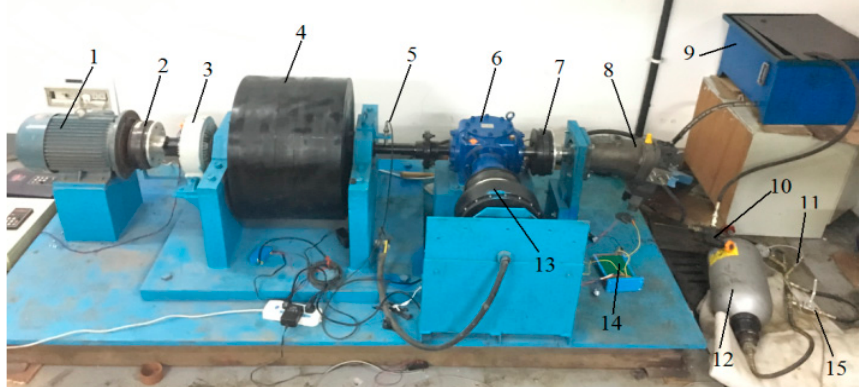
Figure 2. The HRBS test bench . 1—Motor, 2—Electromagnetic clutch No.1, 3—Magnetic powder